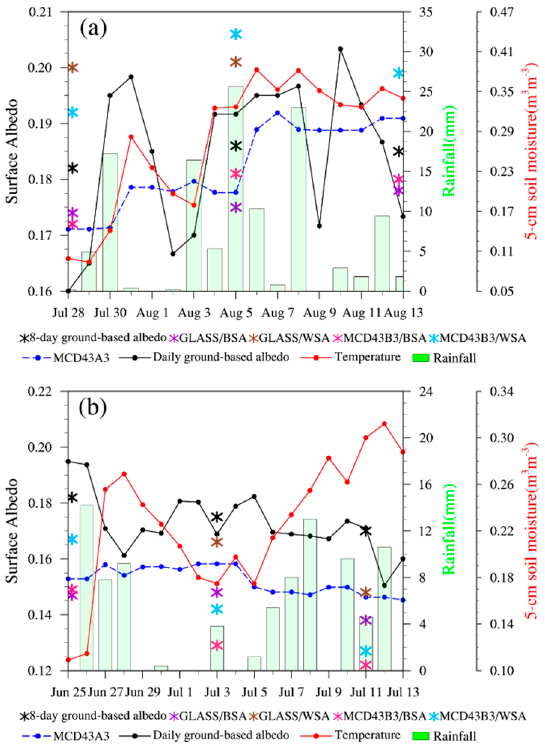
Figure 8. Time series of ground-based albedo, rainfall (units: mm), 5 cm soil moisture (units: m 3 m − 3 ), and satellite-based albedo at the ( a ) Maqu site from 28 July to 13 August 2014 and ( b ) Maduo site from 25 June to 13 July 2012.